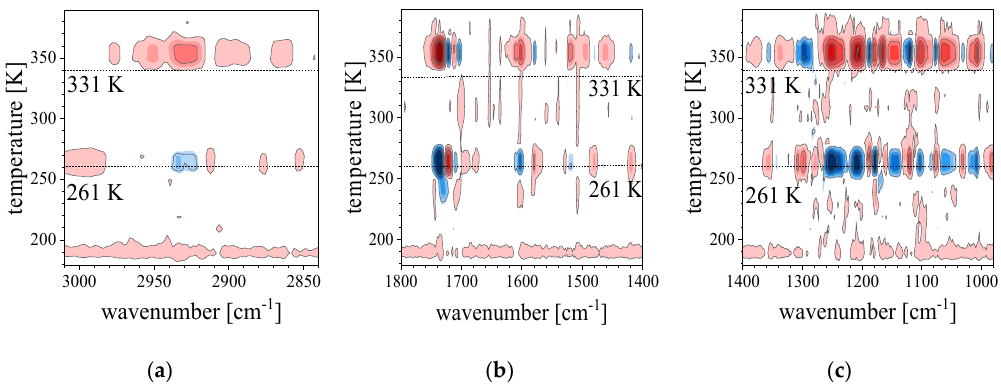
Figure9. PCMW2Dcorrelationsynchronousmapsintheheatingmodeof3F7HPhH7inthewavenumber Figure 9. PCMW2D correlation synchronous maps in the heating mode of 3F7HPhH7 in the wavenumber regions of: ( a ) 3100–2800 cm –1 , ( b ) 1800–1400 cm –1 and ( c ) 1400–1000 cm –1 . The red or regions of: ( a ) 3100–2800 cm − 1 , ( b ) 1800–1400 cm − 1 and ( c ) 1400–1000 cm − 1 . The red or blue areas blue areas represent positive or negative correlation intensities, respectively. represent positive or negative correlation intensities,